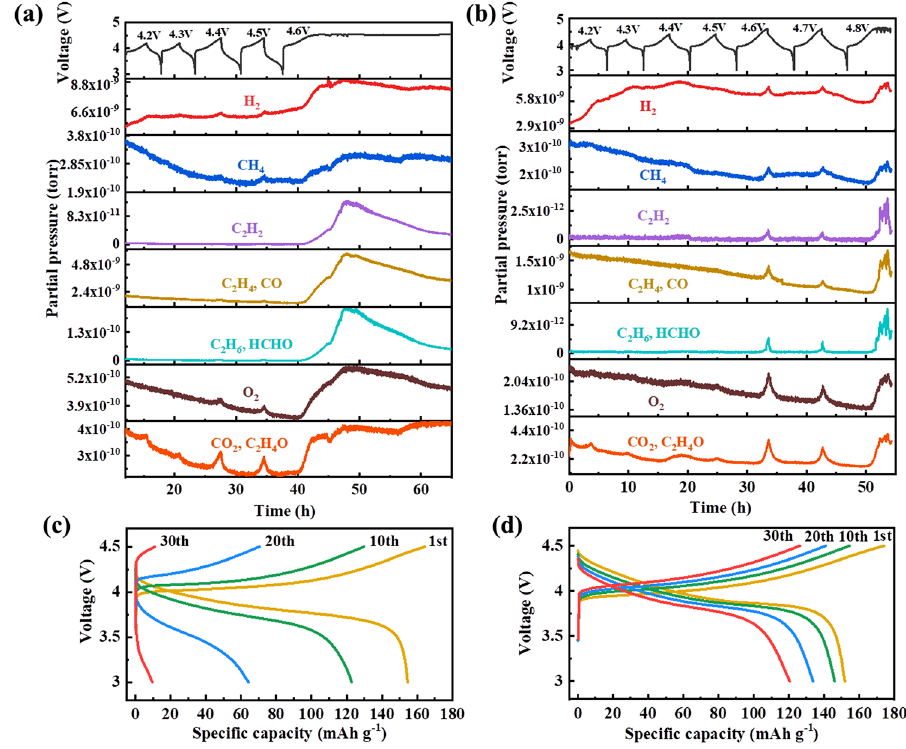
Fig. 4 Voltage profile and corresponding in situ DEMS results of mass signals m/z 2(H 2 ), 16 (CH 4 ), 26 (C 2 H 2 ), 28 (CO, C 2 H 4 ), 30 (C 2 H 6 , HCHO), 32 (O 2 ) and 44 (CO 2 , CH 3 CHO) of a LCO/PEO-LiTFSI/Li cell and b LAF@LCO/PEO-LiTFSI/Li cell cycled in the voltage ranges of 3.0–4.2, 3.0–4.3, 3.0–4.4, 3.0–4.5, 3.0–4.6, 3.0–4.7, 3.0–4.8 V for one cycle at 60 °C. A final charging to 4.8 V leads to the cell failure. The charge/discharge profiles of c LCO/PEO-LiTFSI/Li cell and d LAF@LCO/PEO-LiTFSI/Li cell. The cells are charged at a constant current den- sity of 0.5C to 4.5 V and followed by discharging to 3.0 V at 0.2C at 60